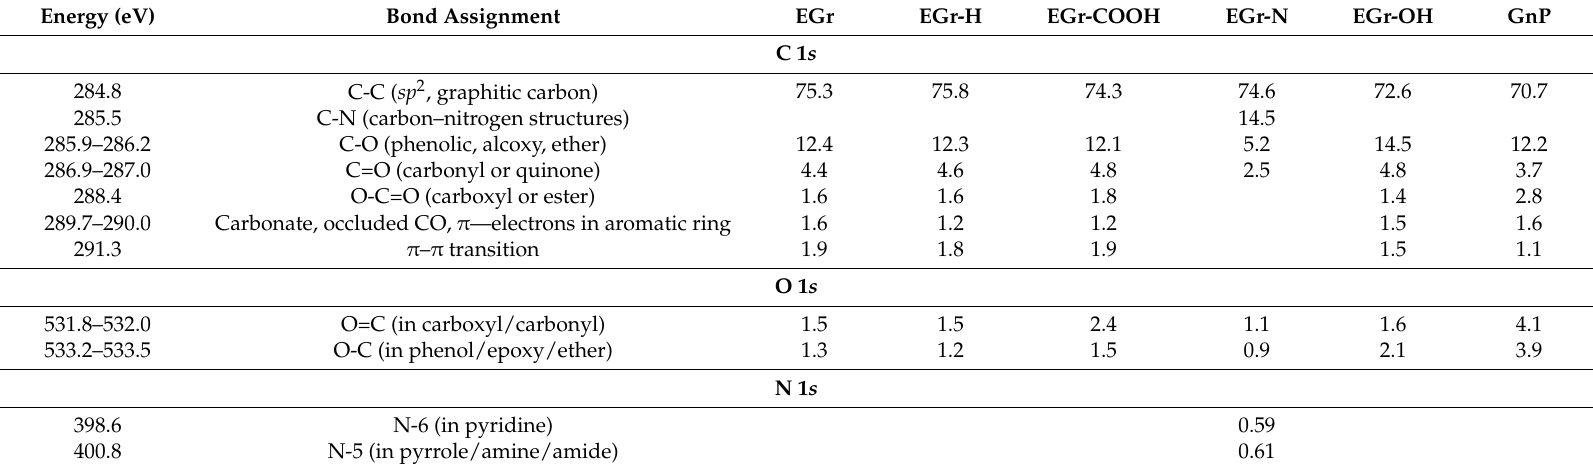
Table 2. Surface concentration (atomic %) of carbon, oxygen and nitrogen species obtained by deconvolution of C 1 s , O 1 s and N 1 s core energy